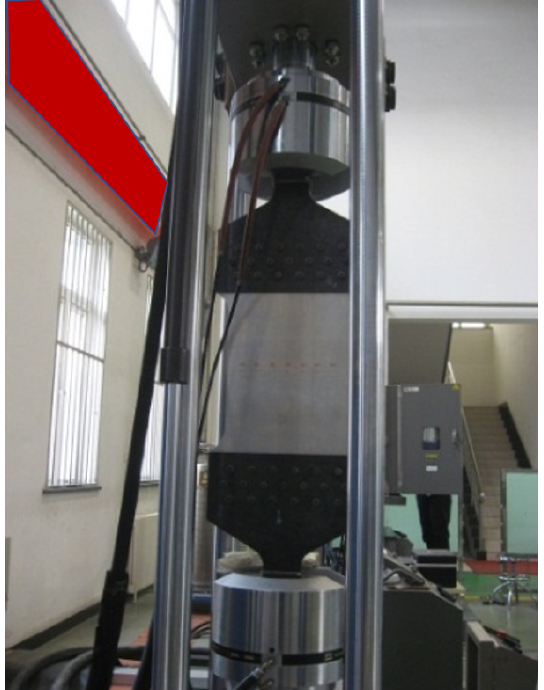
Figure 16. Site drawing of seven-hole collinear plate